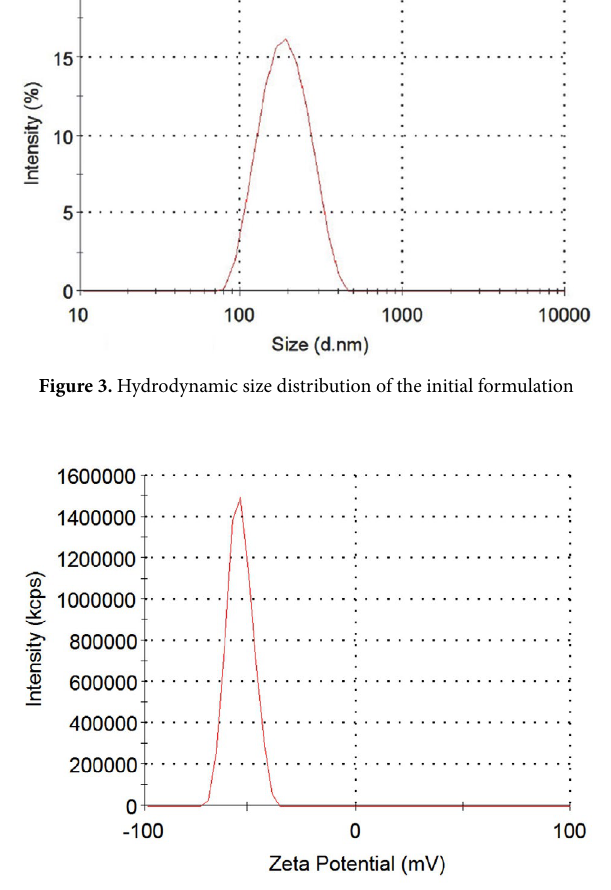
Figure 4. Zeta potential distribution of the initial formulation